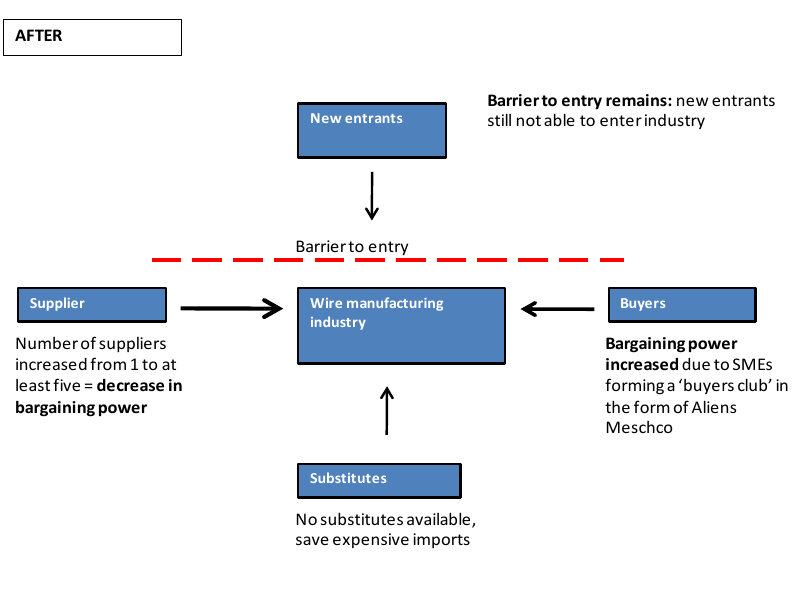
FIGURE 6: Actions of the Allens Meshco group in counteracting anti-competitive conduct in the wire Industry Source: Compiled by